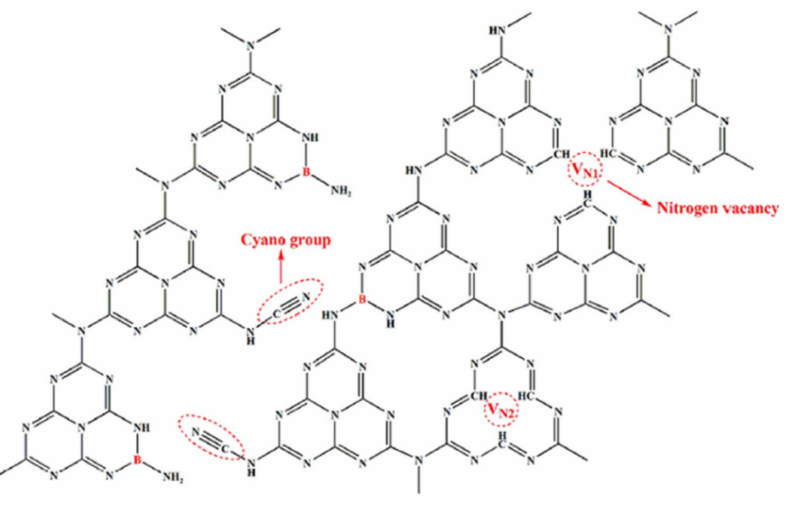
Figure 19. The structure of B, cyano-GCN. Reproduced with permission from Ref.